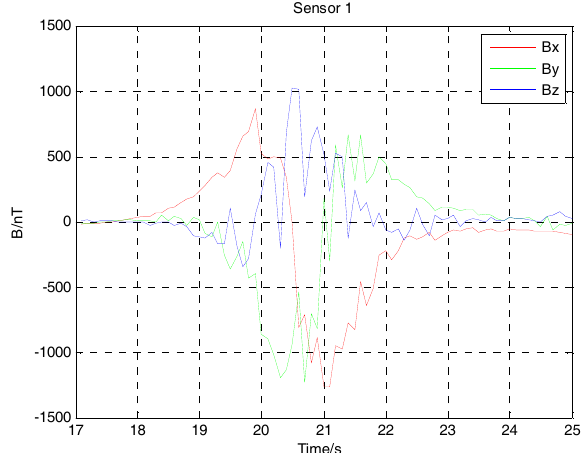
Figure 16. Magnetic field data acquired by three-component fluxgate sensor 1.